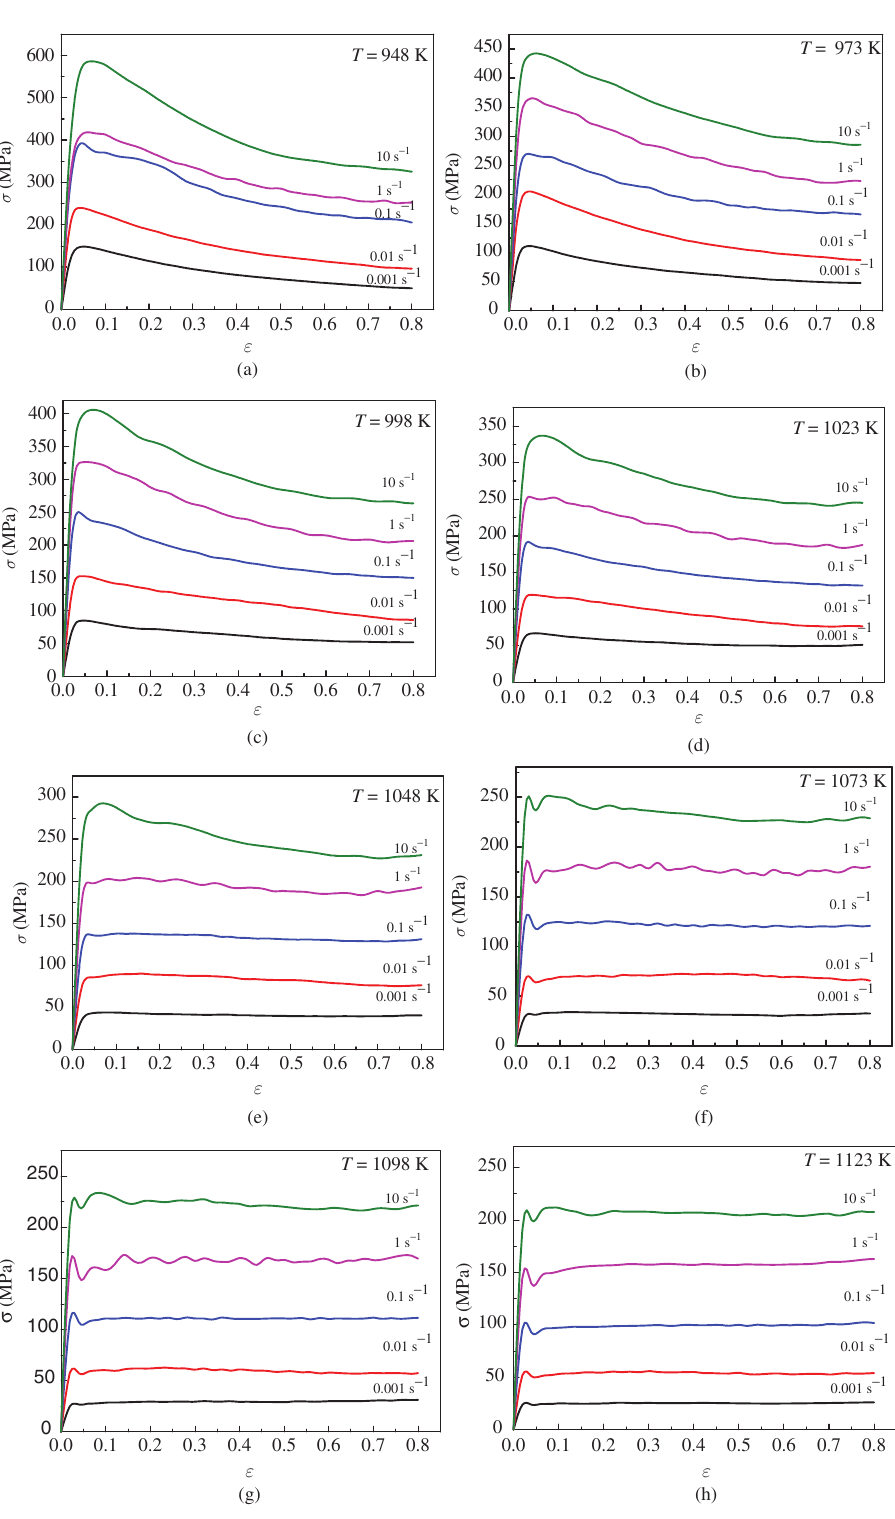
Figure 2 The true stress – strain curves of as-forged Ti-10V-2Fe-3Al alloy under the different strain rates with temperatures of (a) 948 K, (b) 973 K, (c) 998 K, (d) 1,023 K, (e) 1,048 K, (f) 1,073 K, (g) 1,098 K, (h) 1,123